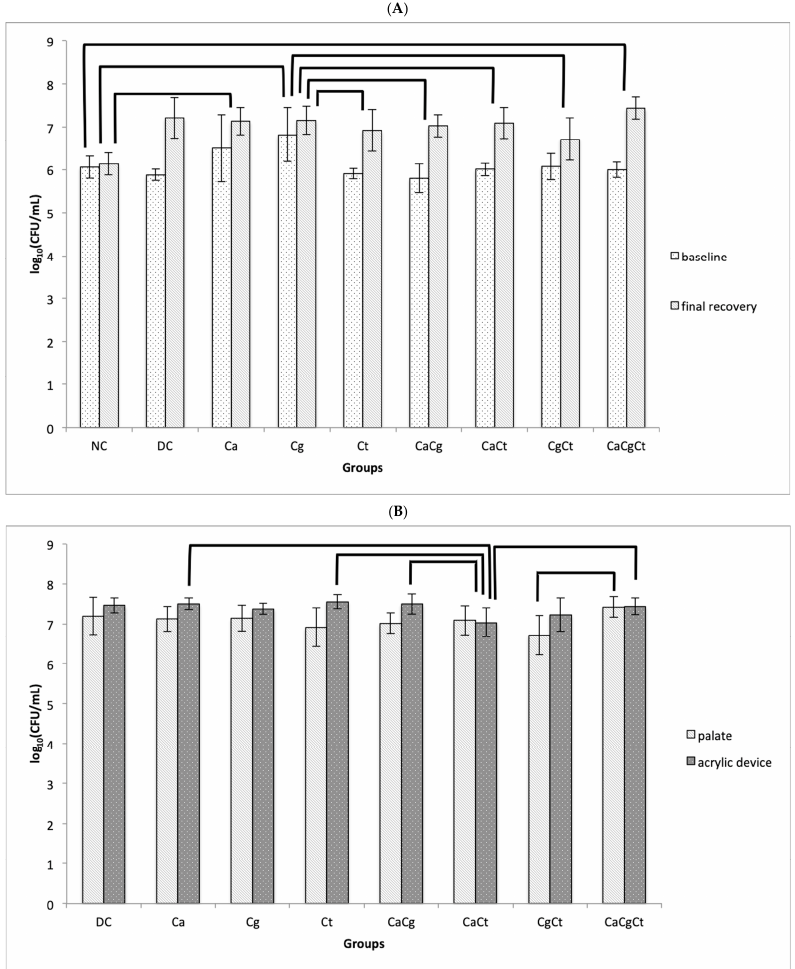
Figure 1. Mean values of log 10 (CFU/mL) of the total cultivable microbiota (BHI) from the rats’ palate and device: ( A ) Initial (baseline) and final recovery from the rats’ palate; ( B ) Final recovery from the palate and the acrylic device. Error bars: standard deviation ( n = 10, males and females); brackets show significant difference ( p < 0.05) among the groups. NC: negative control; DC: device control, Ca: Candida albicans , Cg: Candida glabrata , Ct: Candida tropicalis , CaCg: C. albicans + C. glabrata , CaCt: C. albicans + C. tropicalis , CgCt: C. glabrata + C. tropicalis , and CaCgCt: C. albicans + C. glabrata + C. tropicalis groups.